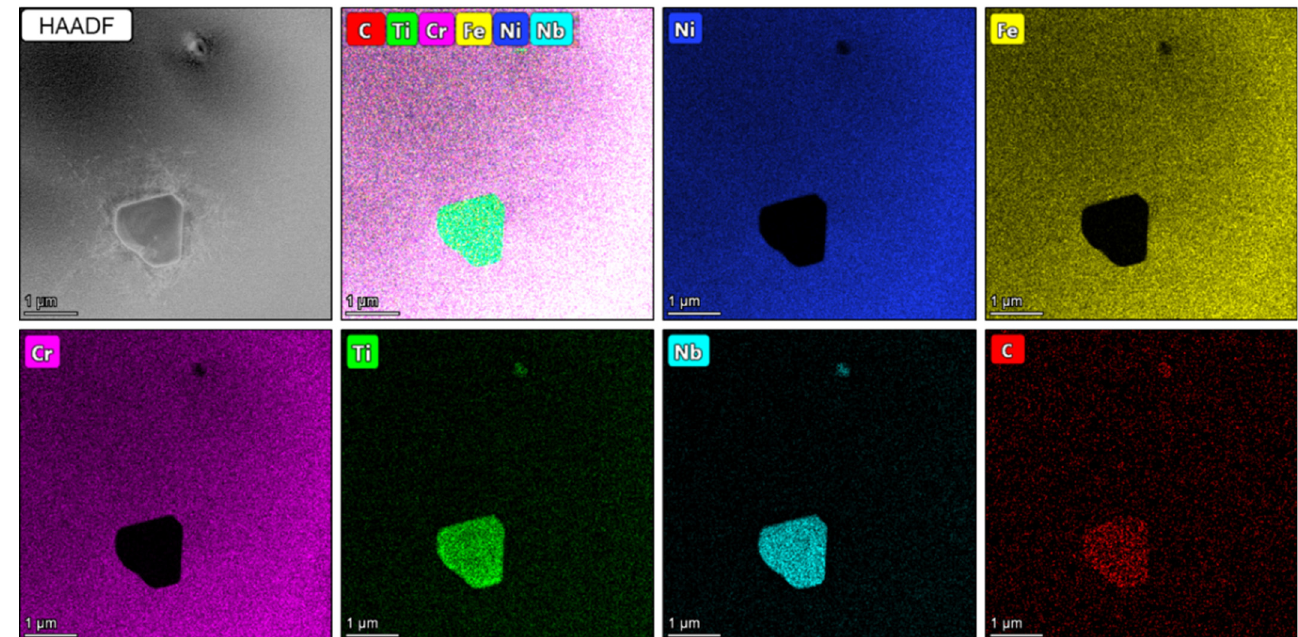
Figure 2. Bright-field images of the wrought 945A Ni-based alloy: ( a ) morphology of low magnifi- cation, ( b ) high magnification of the second phase in ( a ), ( c ) the residual dislocations.